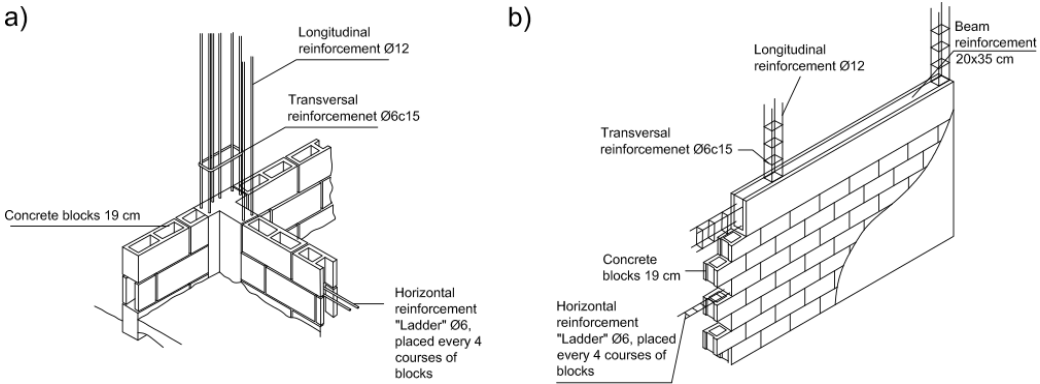
Figure 7. Arrangement of blocks. ( a ) assembly I; ( b ) assembly II.